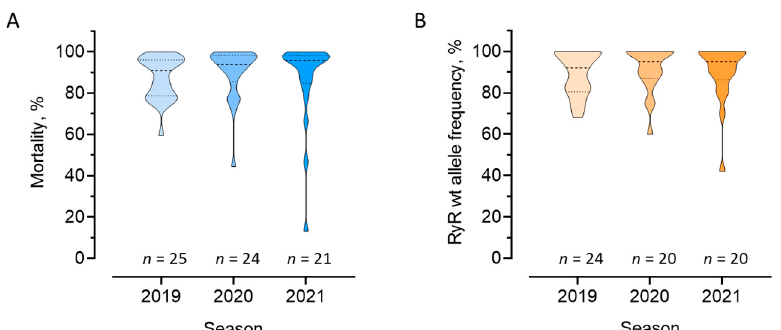
Figure 1. Phenotyping and genotyping of diamide resistance in Brazilian Spodoptera frugiperda sampled across three seasons. Violin plots of the efficacy of a discriminating rate of flubendiamide (diet-overlay assay, 0.41 µ g a.i./cm 2 ) against 70 field populations of fall armyworm ( A ), and ryanodine receptor (RyR) I4790 wildtype (wt) allele frequency in 64 fall armyworm populations ( B ), sampled across three cropping seasons (2019–2021). One-way ANOVA and Tukey’s post-hoc multiple comparisons test revealed no significant differences between seasons ( p > 0.05).